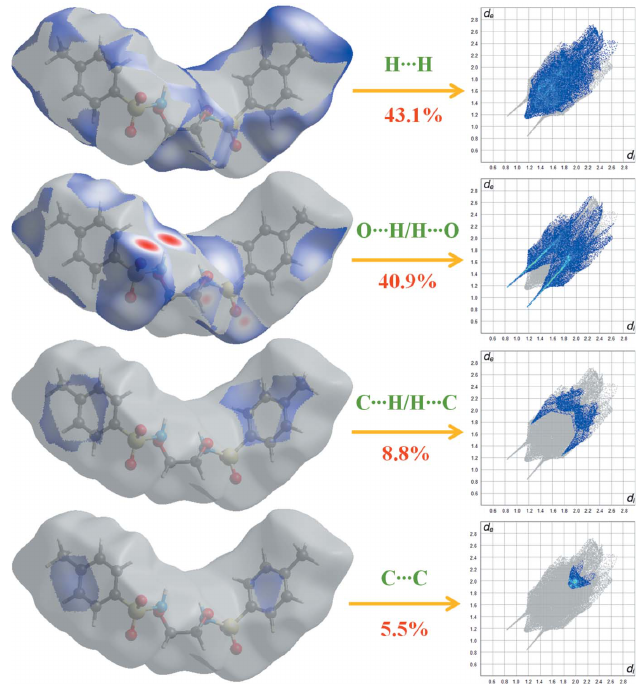
Figure 7 Two-dimensional fingerprint plots with a d norm view of the H (cid:2)(cid:2)(cid:2) H (43.1%), O (cid:2)(cid:2)(cid:2) H/H (cid:2)(cid:2)(cid:2) O (40.9%), C (cid:2)(cid:2)(cid:2) H/H (cid:2)(cid:2)(cid:2) C (8.8%) and C (cid:2)(cid:2)(cid:2) C (5.5%) contacts in the title